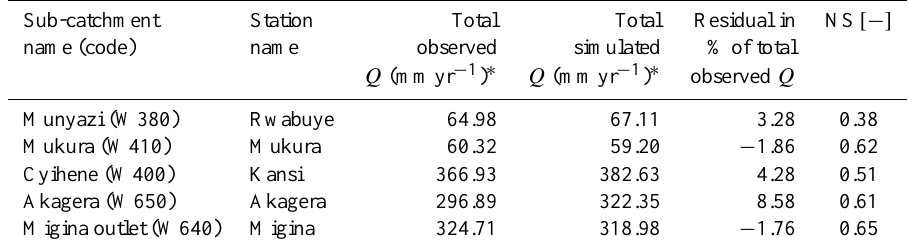
Table 3. Residual values for each discharge computation point with corresponding NS. The simulation period is 12 months (1 August 2009 to 31 July 2010). The positive sign ( + ) means that the model overestimated the flows, while the negative sign ( − ) means that the model underestimated the